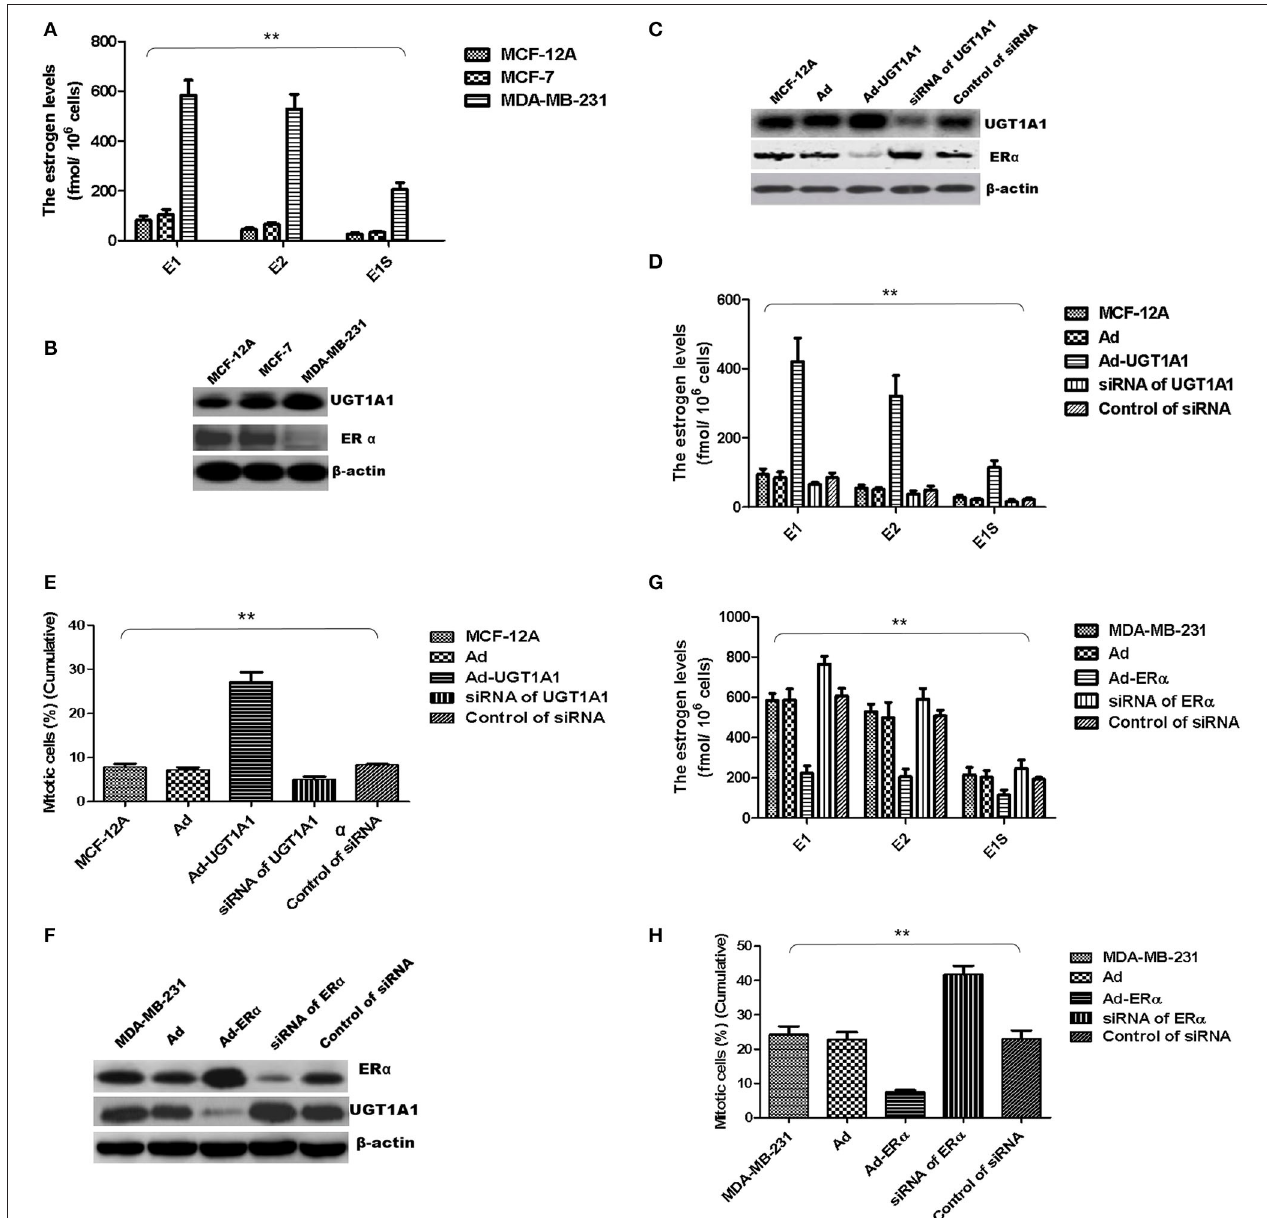
FIGURE 6 | UGT1A1 induced production of intracellular estrogens. At first, the intracellular estrogen products in human mammary gland cell line MCF-12A, human breast cancer cell line MCF-7, and triple-negative breast cancer (TNBC) subtype cell line MDA-MB-231 were determined, respectively. In MDA-MB-231 cells, the productions of E1, E2, and E1S were all remarkably greater than that in MCF-12A and MCF-7. However, there was no significant difference between MCF-12A and MCF-7 (A) . Moreover, the expression levels of ER α and UGT1A1 were detected in these cell lines (B) . The results showed that the expression of UGT1A1 in MDA-MB-231 was much greater than MCF-12A and MCF-7, but the ER α expression in MDA-MB-231 was lower than MCF-12A and MCF-7. Meanwhile, the expression of UGT1A1 in MCF-7 was slightly more than MCF-12A, but there was no significant difference. Besides, the expression level of ER α in MCF-7 was slightly lower than MCF-12A, but there was no significant difference (B) . In cell line MCF-12A, overexpression of UGT1A1 downregulated the expression of ER α (C) , and then resulted in an obvious increase of intracellular estrogen products (D) . Meanwhile, Ad-UGT1A1 promoted markedly the cell proliferation of MCF-12A (E) . Besides, overexpression of ER α was induced in cell line MDA-MB-231, which caused the downregulation of UGT1A1 (F) and marked decrease of intracellular estrogen products (G) . Meanwhile, Ad-ER α significantly reduced cell proliferation of MDA-MB-231 (H) . ** P < 0.01.